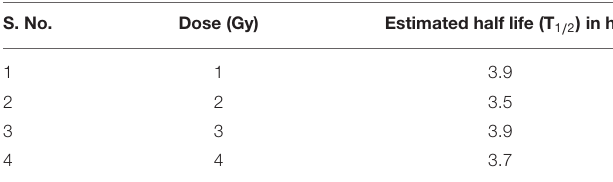
TABLE 2 | Half-lives of phospho-53BP1 foci for doses of 1, 2, 3, and 4Gy estimated using the formula T1/2 = 0.693*t1. S. No. Dose (Gy) Estimated half life (T 1 / 2 ) in